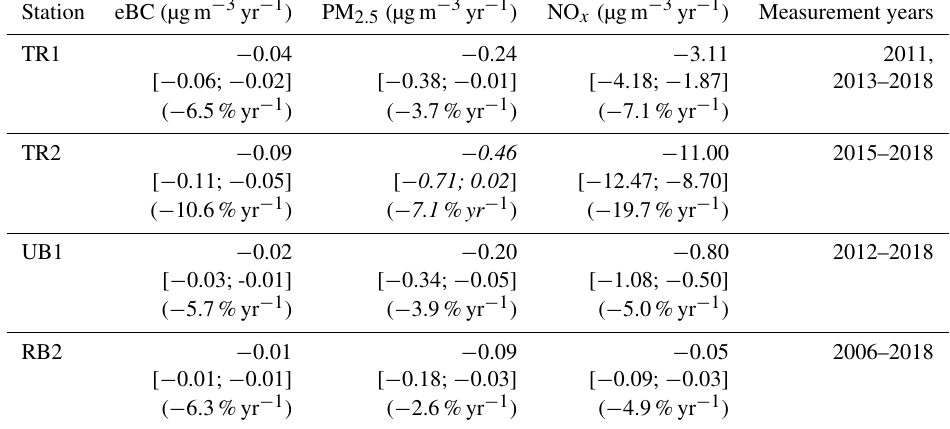
Table 3. Results of the trend analysis of the eBC, PM 2 . 5 , and NO x concentrations. The values without brackets are the absolute trends (in units of µgm − 3 yr − 1 ), the values in the square brackets are the 5th and 95th uncertainty limits of the trend (in units ofµgm − 3 yr − 1 ), and the bracketed values are the relative trends (in units of %yr − 1 ). The values for PM 2 . 5 at TR2 are italicized since they were statistically not significant ( p value =